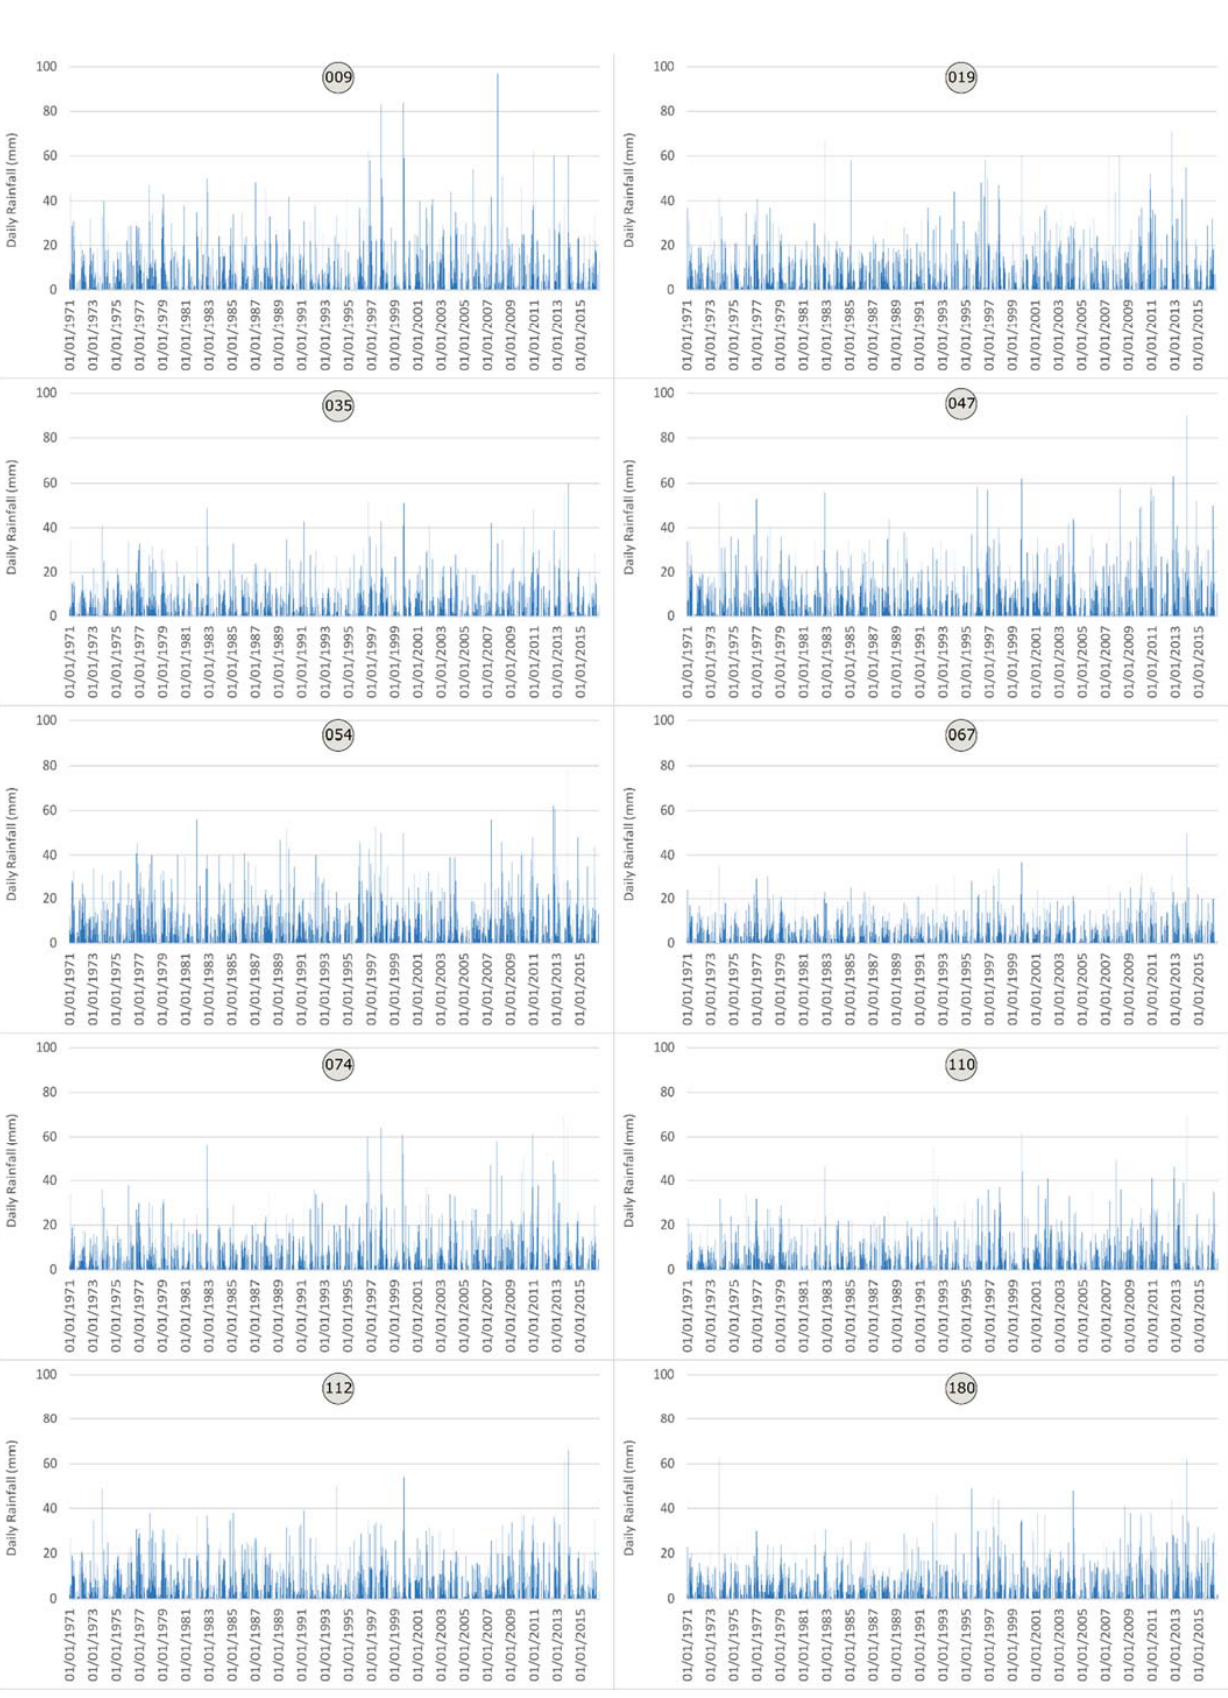
Figure 4. Rainfall series of the incidence points shown in Figure 3.